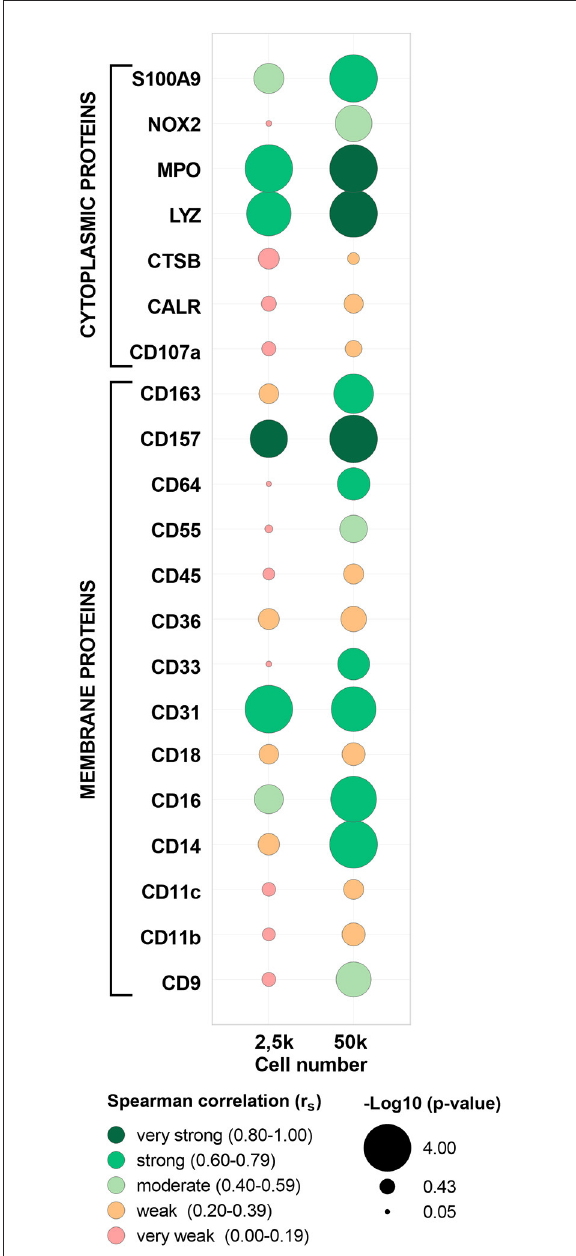
FIGURE6 Correlation between abundance ratios (vs. classical monocytes, cMo) of selected proteins from paired samples in flow cytometry (FCM) and mass spectrometry (MS). Each bubble includes data for each protein and cell number (2.5 or 50k) from cMo, non-classical monocytes, intermediate monocytes, glioblastoma macrophages/microglia and T cells from peripheral blood. Bubble colors indicate the Spearman correlation value and bubble size is proportional to -log10 ( p -value) as indicated below the panel. CD68 and CD282 proteins were not included as no quantification values were calculated by MS. MPO , myeloperoxidase; LYZ , lysozyme C; CTSB , cathepsin B; CALR ,